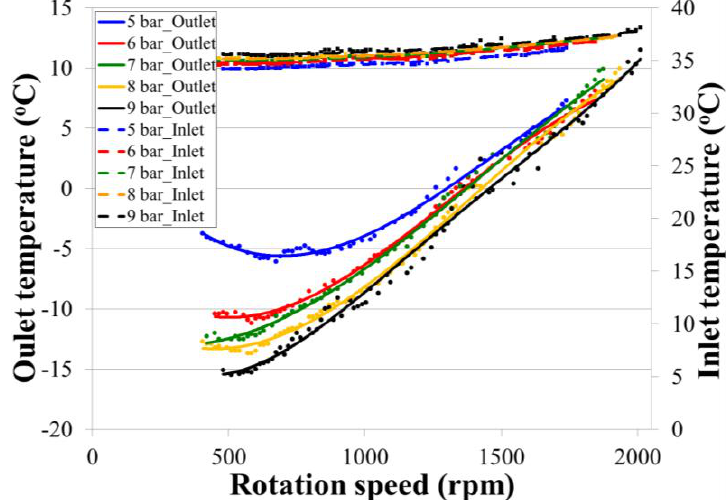
Figure 10. The inlet and outlet temperature variation at different rotation speeds and supplying air